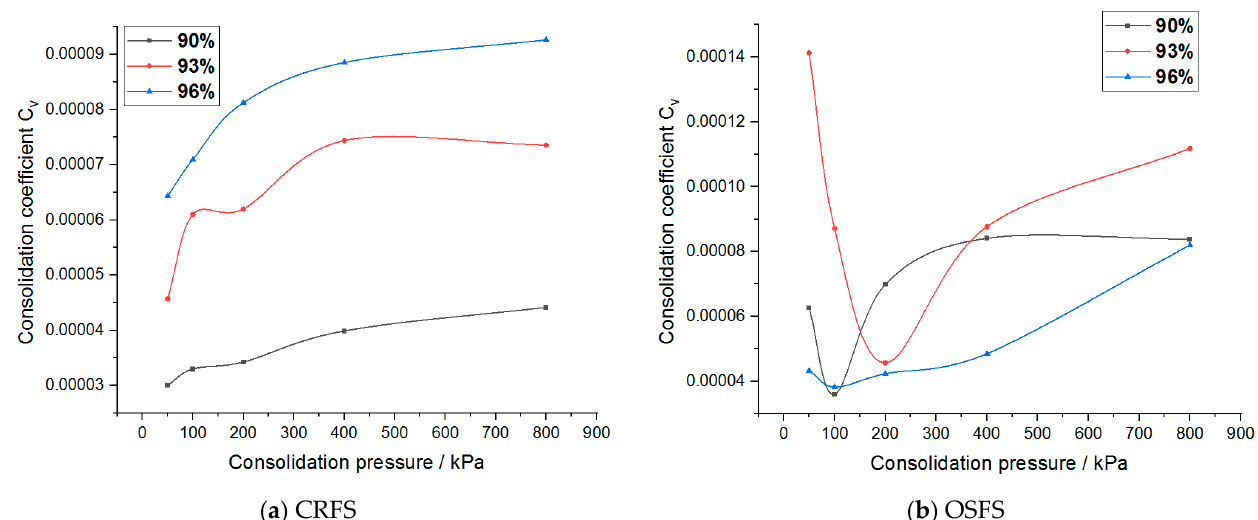
Figure 19. Consolidation coefficient of modified soil with different compaction degrees.